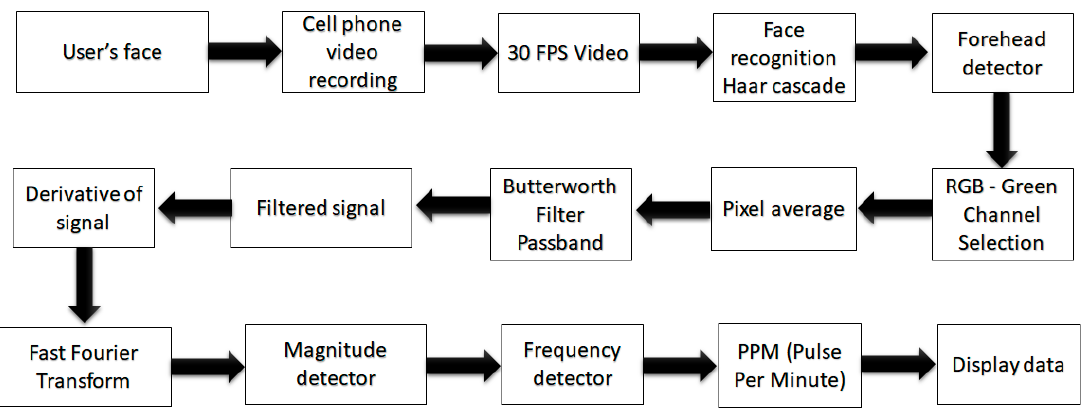
Figure 1. Methodology of the estimated hearth rate solution.